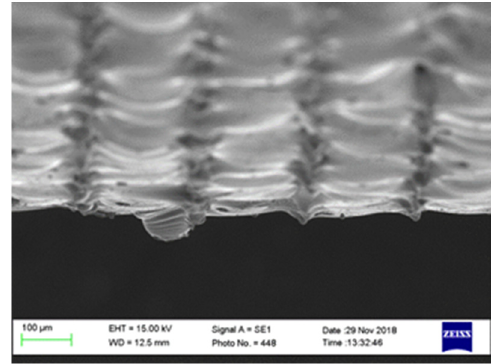
Figure 9. SEM image of a remaining unmelted particle due to lack of fusion. Materials 2019 , 12, x FOR PEER REVIEW